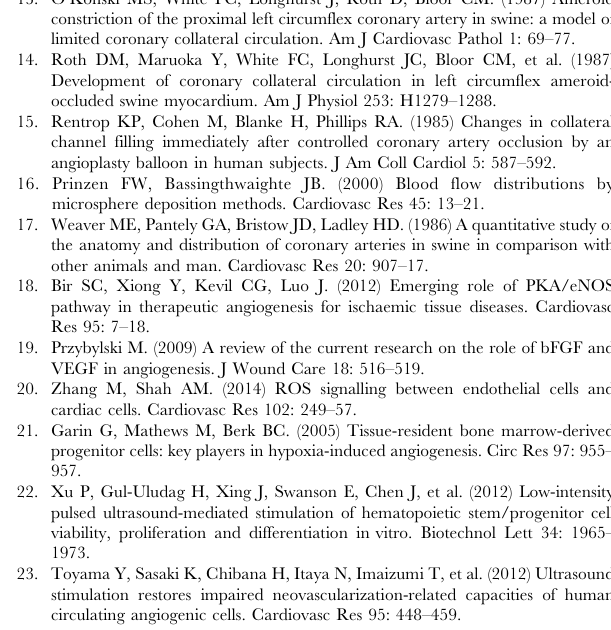
Figure S3 LIPUS therapy enhanced coronary angiogenesis in vivo. ( A , B ) Four weeks after the implantation of an ameroid constrictor (pre-Tx) LCx was totally occluded and was perfused via collateral vessels with severe delay in both the control group ( A ) and the LIPUS group ( B ). ( C , D ) Four weeks after the first coronary angiography (post-Tx), no significant change in coronary vessels was noted in the control group ( C ), whereas a marked development of visible coronary vessels was noted in the LIPUS group ( D ). ( E , F ) Four weeks after the first coronary angiography, no significant increase in the Rentrop score ( E ) or visible coronary arteries from LCx ( F ) was noted in the control group, whereas increased Rentrop score and a marked development of visible coronary vessels were noted in the LIPUS group. Results are expressed as mean 6 SEM (n= 9 each). Table S1 The relationships between voltage and acous- tic pressure. Table S2 Findings of left ventriculography and echo-